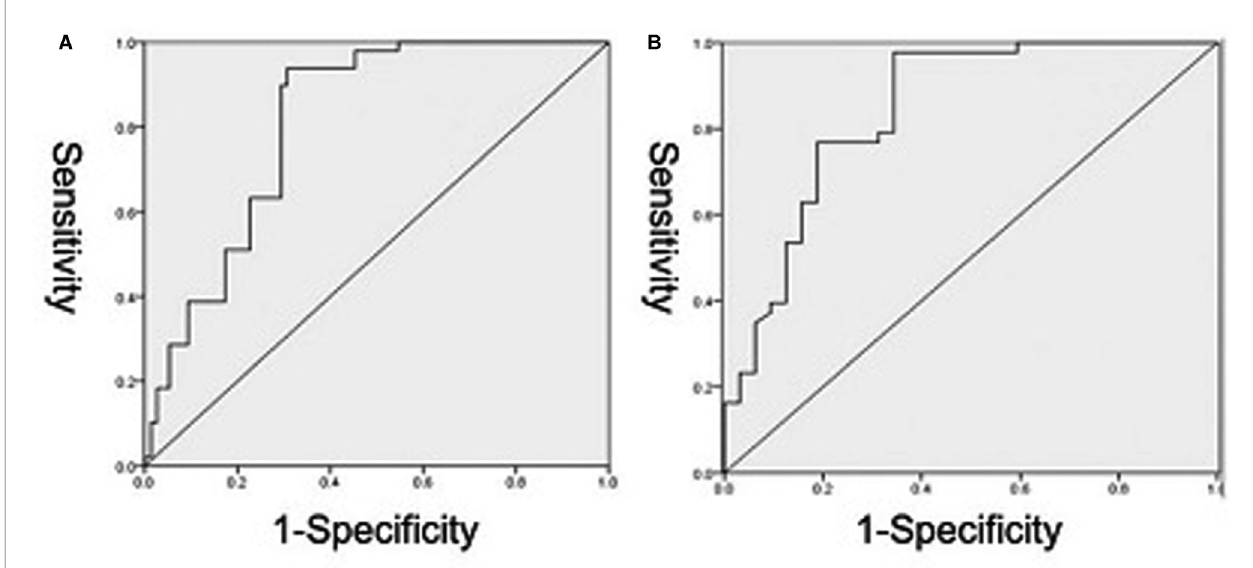
FIGURE 2 | ROC curve to determine the cutoff value of UMI for discriminating tear ( A ) and tear size ( B ). The reference line is indicated in green. The values of area under the curve were 0.798 and 0.843, respectively.